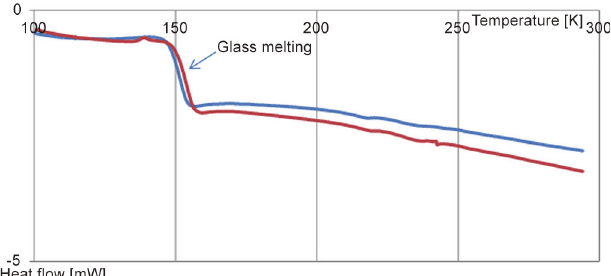
Fig 6. DSC temperature scan. Fully protiated sample — blue curve and fully deuteriated sample — red